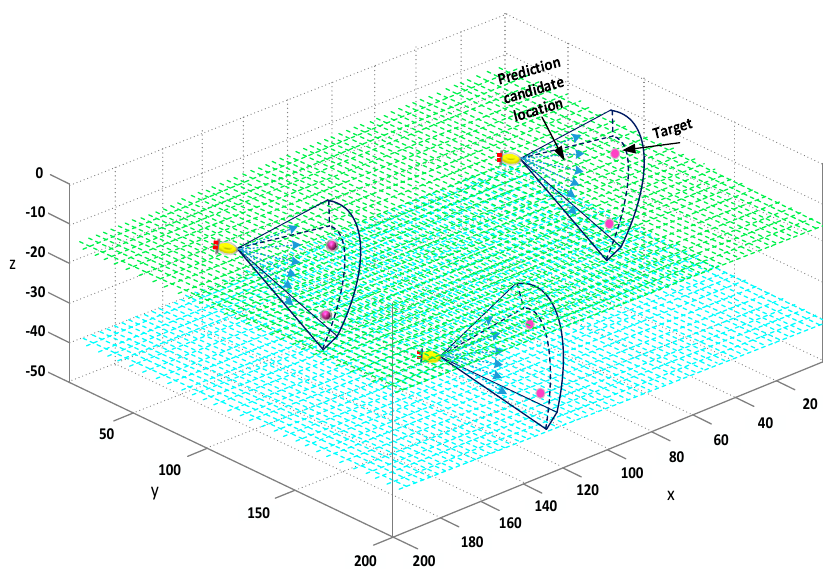
Figure 4. Location prediction.